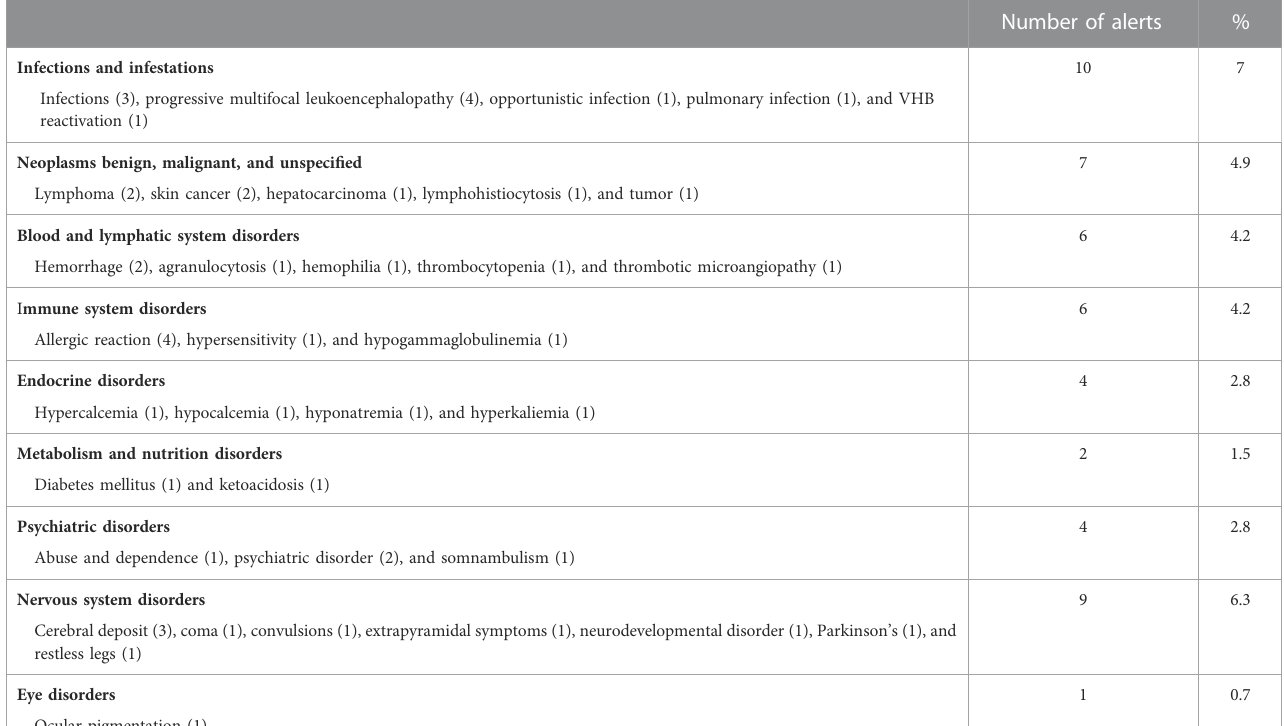
TABLE 2 ADRs classi fi ed according to MedDRA ’ s SOC